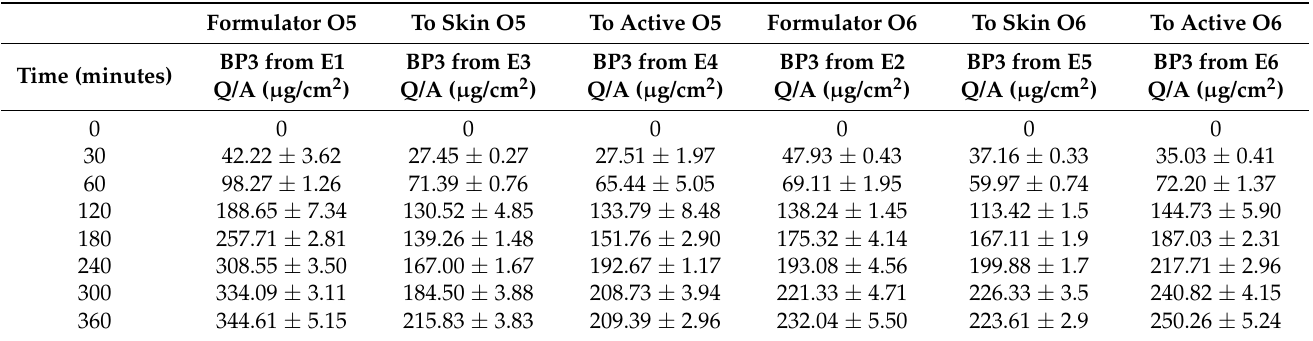
Table 14. Cumulative BP-3 release from all prepared formulations. Q is the quantity of compound traversing the membrane in time t, and A is the area of exposed membrane in cm 2 . Each value was obtained from four experiments (mean ±